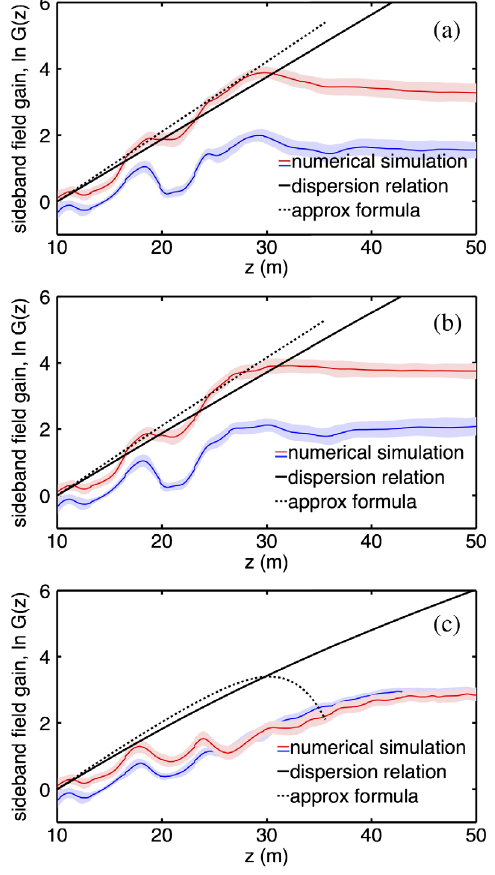
FIG. 4. Sideband field gain ln G ð z Þ as a function of z for (a) untapered, (b) 0.8%-tapered, and (c) 10%-tapered cases. The numerical simulations are averaged results from 50 independent runs. The solid lines are obtained from solving Eq. (20) and the dashed lines are evaluated by Eqs. (22) and (28). The shaded error bars, denoted as statistical fluctuations ( (cid:5) 1 σ ) from each inde- pendent 1-D FEL numerical simulations, are marked with red and blue and correspond to the lower and upper sideband signals,